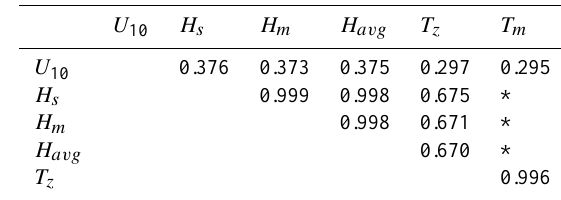
Table 1. Correlation coefficients of the analysed wave parameters and wind speed.